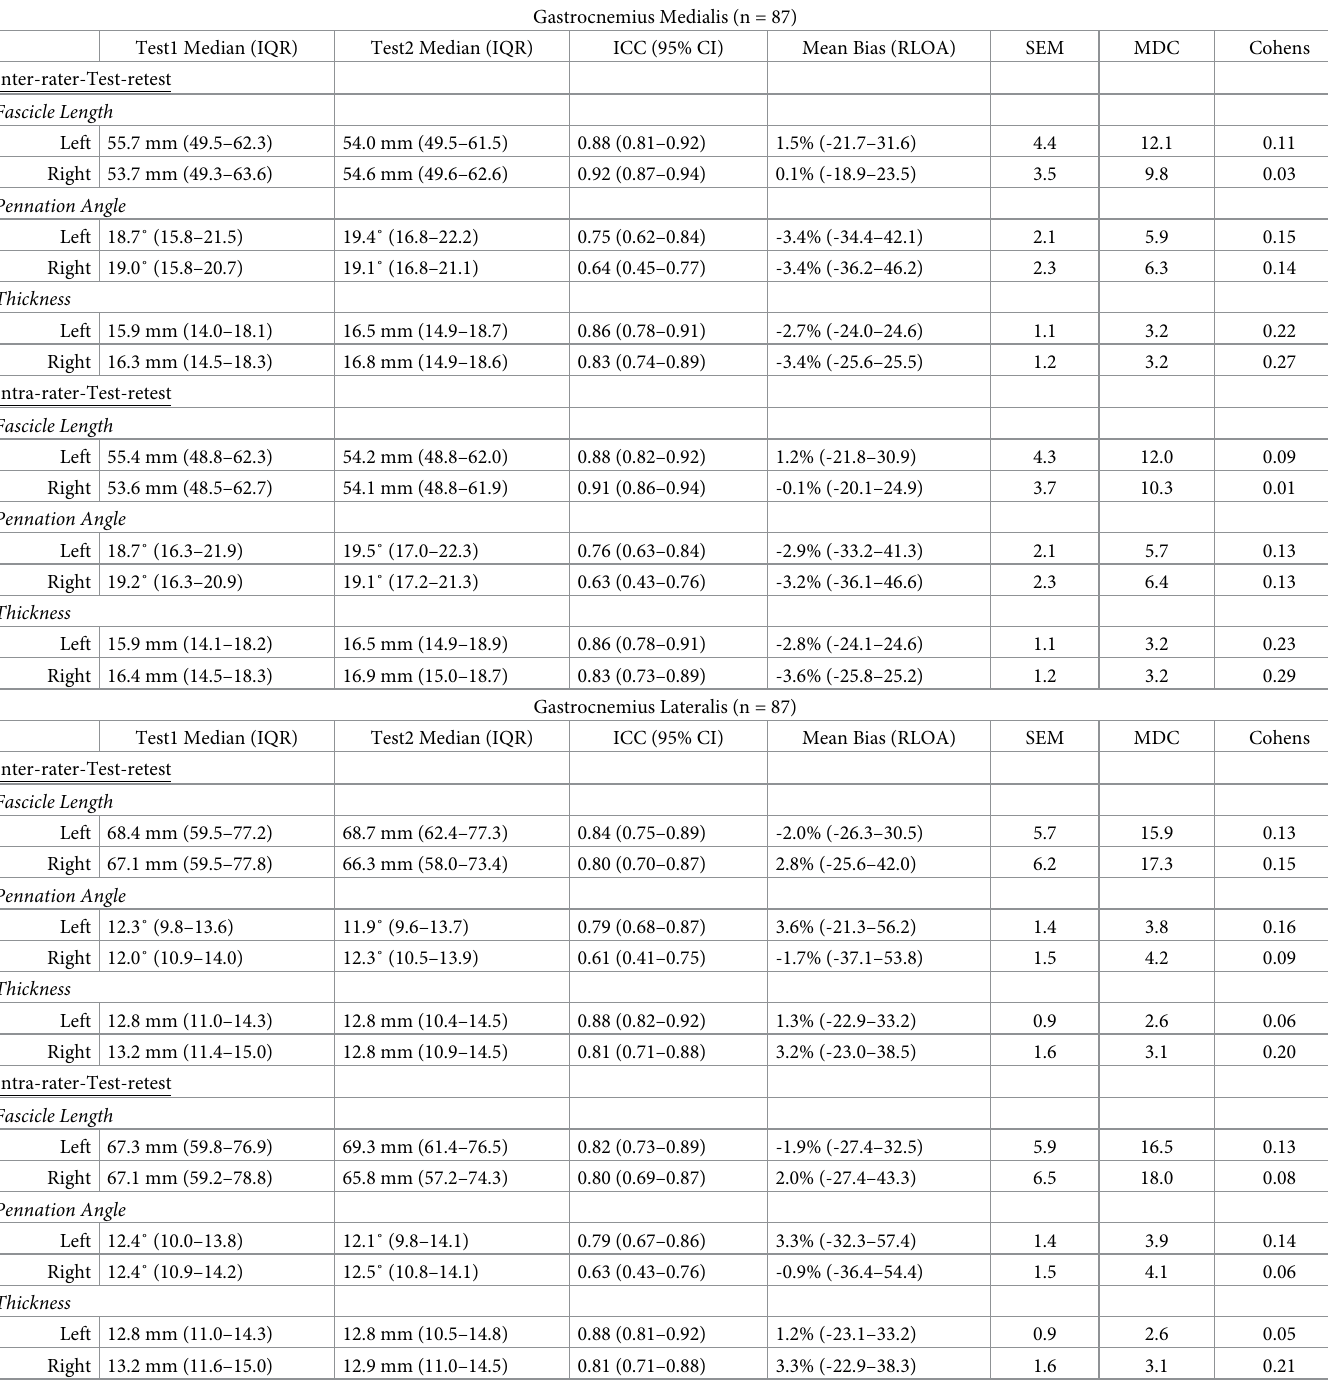
Table 2. Test-retest reliability for fascicle length, pennation angle and muscle thickness of the gastrocnemius medialis and gastrocnemius lateralis